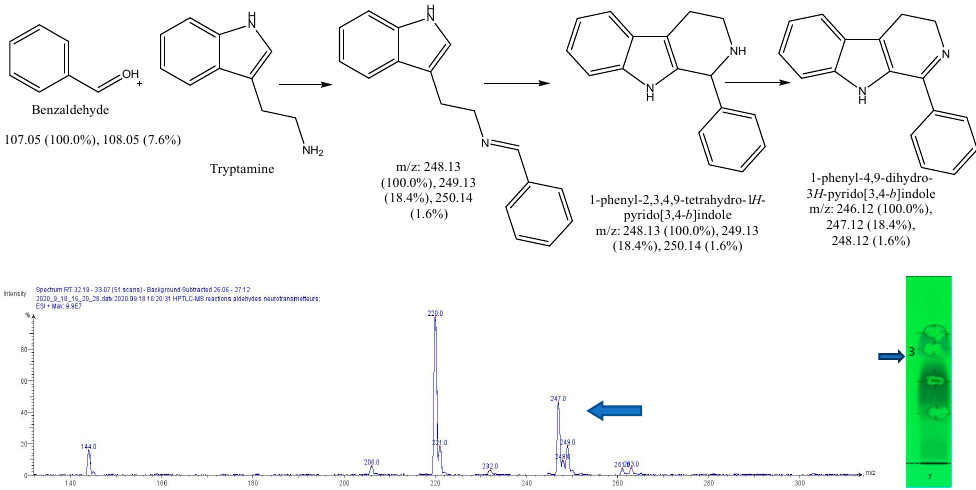
Figure 13. Expected reaction between tryptamine and benzaldehyde. Mass spectrum for the 3rd spot of the reaction mixture on MS grade TLC plate.